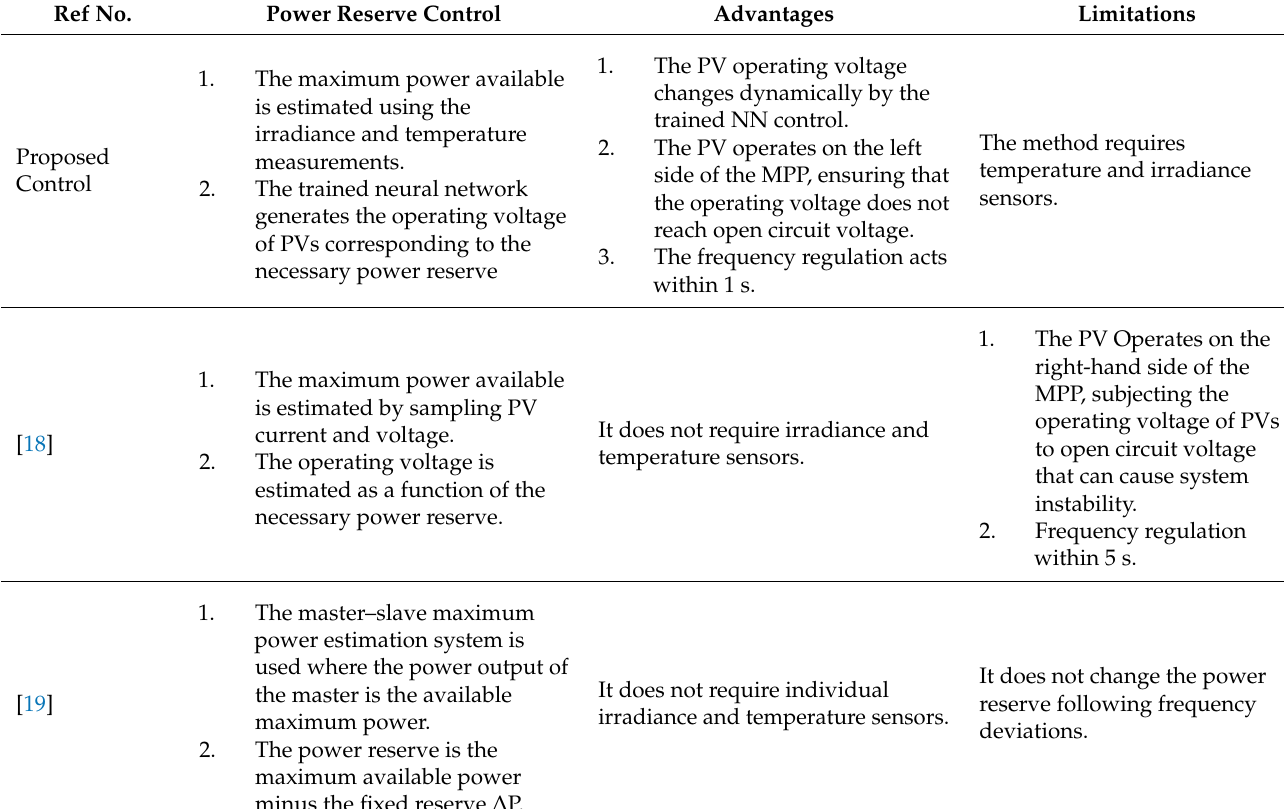
Figure 14. PV output voltage waveform for fixed and variable power reserve control. Table 1. Parameters of PV array.